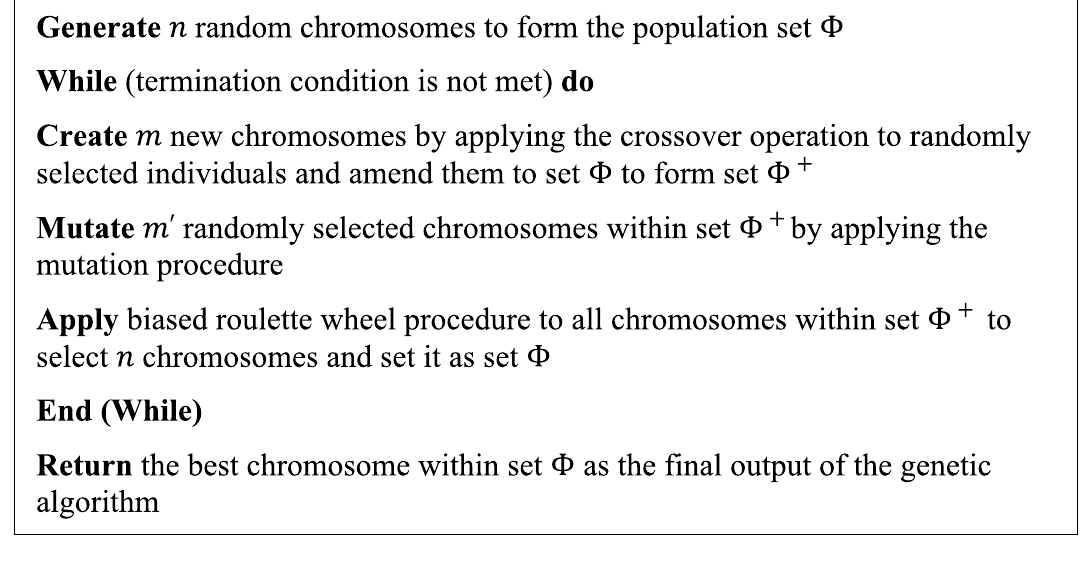
Fig. 3 Pseudocode of the genetic